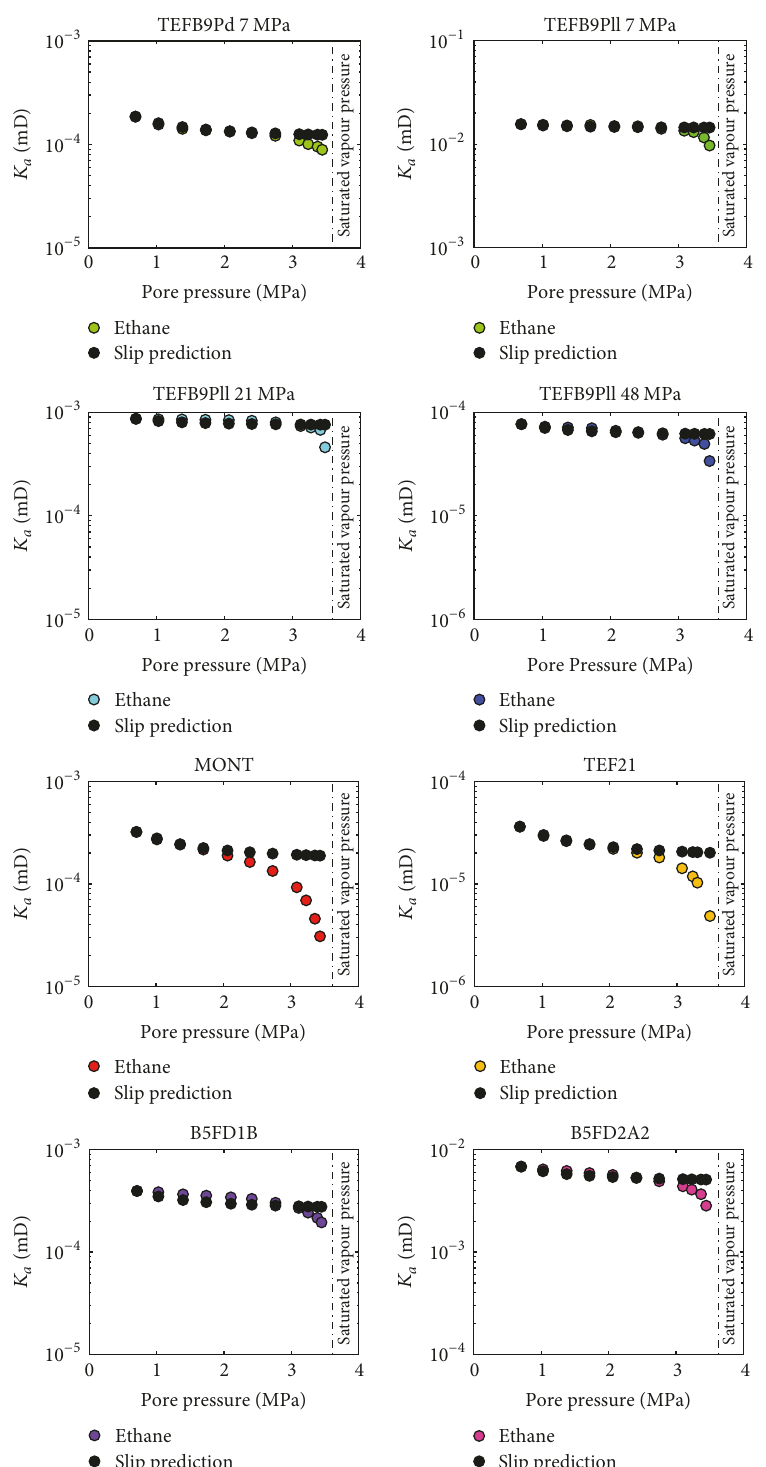
Figure 7: Ethane permeability measurements (coloured markers) and predicted permeability variation due to gas slippage (black markers) calculated using the ethane slippage factor, which was derived from the helium permeability